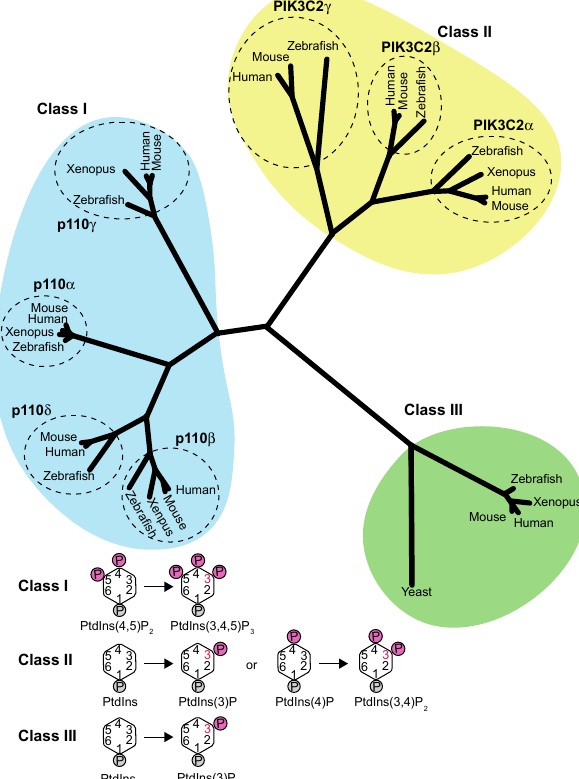
Figure 1. The class III PI3K VPS34/Vps34 is the most ancestral PI3K among the three classes of PI3Ks. The Class I PI3Ks phosphorylate PtdIns(4,5)P 2 to synthesize PtdIns(3,4,5)P 3 , while the Class II PI3Ks phosphorylate PtdIns or PtdIns(4)P to synthesize PtdIns(3)P or PtdIns(3,4)P 2 , respectively. The Class III PI3K (PIK3C3 or VPS34/Vps34 for metazoans/yeast) phosphorylates PtdIns to synthesize PtdIns(3)P. This phylogenetic tree was generated using MEGA (https://www.megasoftware.net/). The following proteins, listed with their Uniprot entry numbers, were used for the analysis: p110 α (Human: P42336; Mouse: P42337; Zebrafish: F1QAD7; Xenopus: F6VXG1); p110 β (Human: P42338; Mouse: Q8BTI9; Zebrafish: E7F251); p110 γ (Human: O00329; Mouse: O35904; Zebrafish: F1RB17); p110 δ (Human:P48736; Mouse: Q9JHG7; Zebrafish: Q6NTI2; Xenopus: A0A6I8RLG9); PIK3C2 α (Human: O00443; Mouse: Q61194; Zebrafish: F6NMW9; Xenopus: B5DE87); PIK3C2 β (Human: O00750; Mouse: E9QAN8; Zebrafish: F1QWN6); PIK3C2 γ (Human: O75747; Mouse: O70167; Zebrafish: A0A0G2L6J0); and PIK3C3/VPS34 (Human: Q8NEB9; Mouse: Q6PF93; Zebrafish: F1Q9F3; Xenopus: F6ZM84; Yeast Vps34: P22543). 2. Basic Architectures of VPS34/Vps34 Complexes I and II VPS34/Vps34, Vps15/Vps15, and Beclin 1/Vps30 (metazoans/yeast) are common sub- units between complexes I and II, whereas ATG14L/Atg14 is complex I-specific and UVRAG/Vps38 is complex II-specific (Figure 2A). Because three of four subunits are shared between them, the structures of complex I and complex II have similar shapes, described as V-shaped or Y-shaped [23,25] (Figure 2B), with VPS34/Vps34-VPS15/Vps15 on one arm (the catalytic arm) and Beclin 1/Vps30-ATG14L/Atg14 or Beclin 1/Vps30-